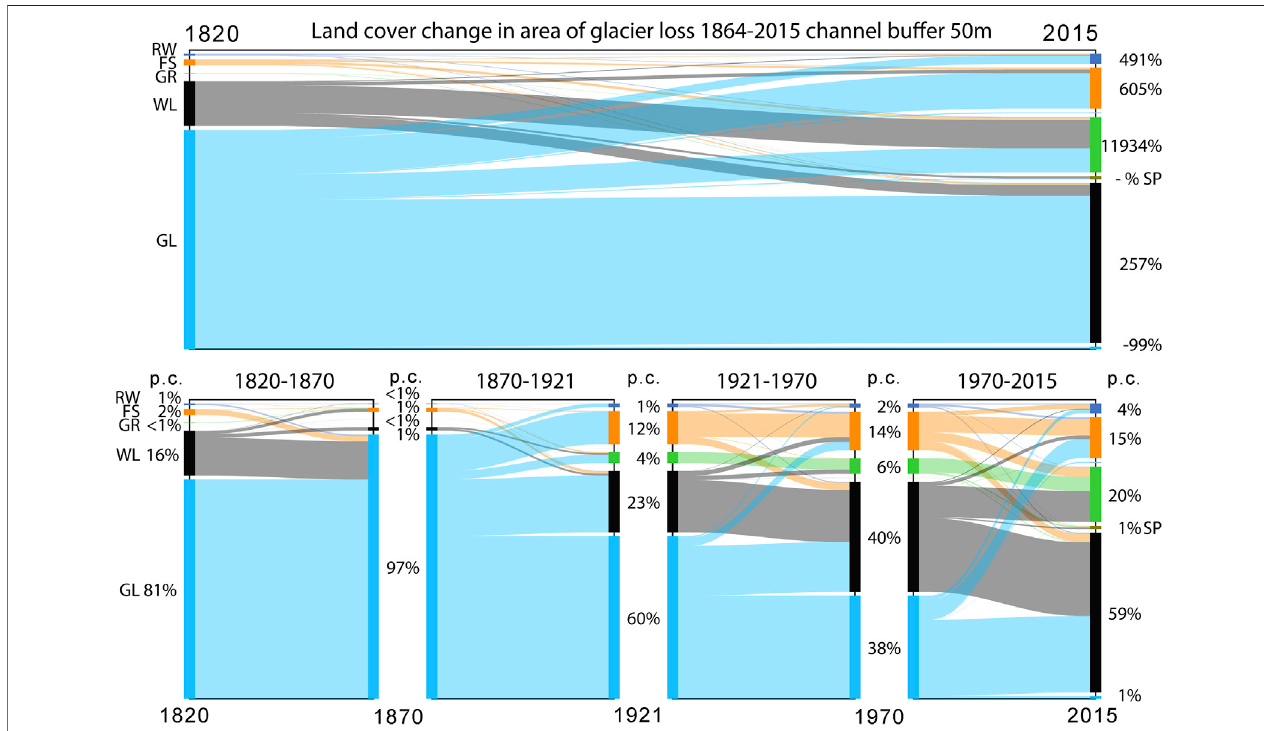
FIGURE 6 | Land cover transformation of the fl uvial corridors 1820 – 2015 in the proglacial area that deglaciated between the maximum extents of the glaciers in 1864 and in 2015(compare Figure 1 ).Fluvial corridors refer toall running waters thatexisted inthat areabetween1820 and 2015 including lateral buffers of50 m. Top: percent values on right margin refer to relative changes from 1820 to 2015. Bottom: percent values refer to percent cover (p.c.) of the fl uvial corridors. Example bottom middle: In 1921, 12% of the fl uvial corridors featured fl uvial sediments (FS, orange). Thereof, until 1970 a marked proportion transformed to wasteland (WL, black/ grey).Inturn,smallerproportionsofformerglaciers(GL,blue)andwasteland(WL)developedto fl uvialsedimentareas(FS).In1970, fl uvialsedimentsmadeup14%ofthe analysed fl uvial corridors. Only land cover types with a signi fi cant proportion are labelled (RW, running water; GR, grassland; SP, sparsely